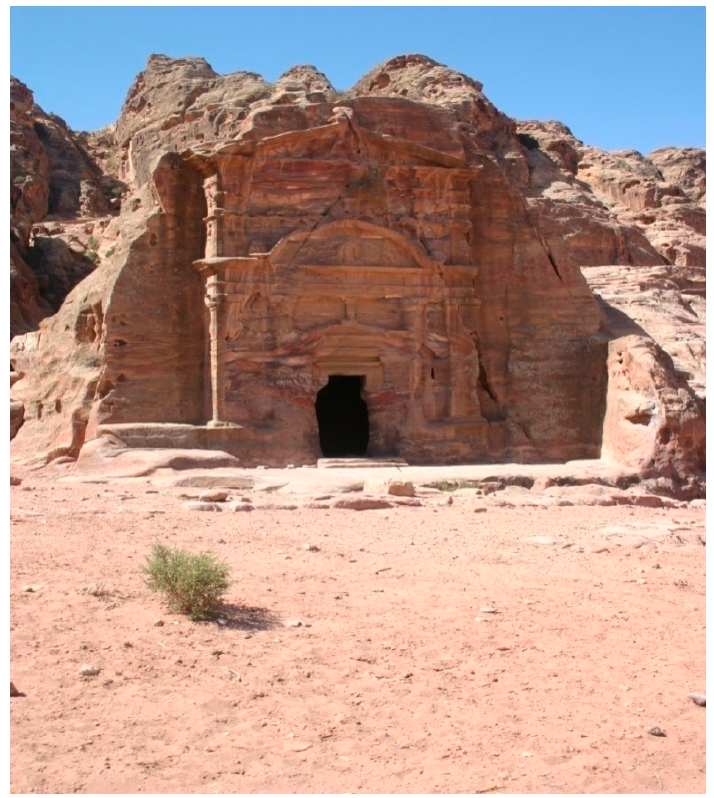
Figure 14. The Sextus Florentinus Tomb below the Wadi Mataha pipeline channel. Water 2020 , 12 , x FOR PEER REVIEW